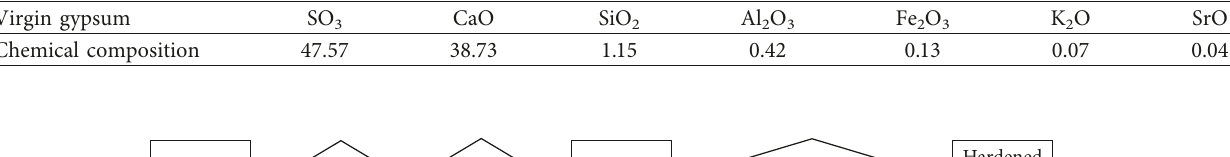
Table 1: Chemical composition of VG used (%).